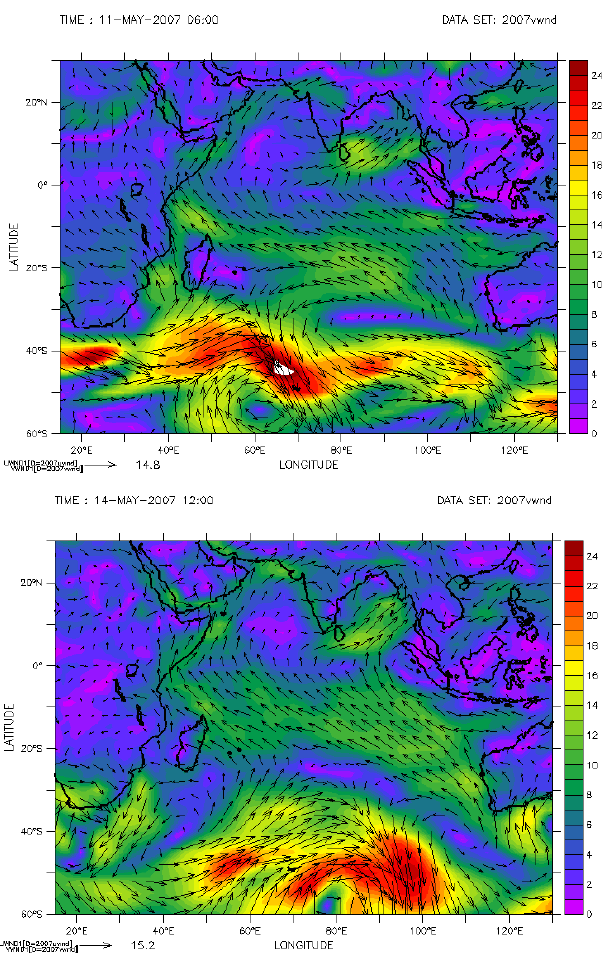
Fig. 7. Major wind systems in the Indian Ocean during May 2007.